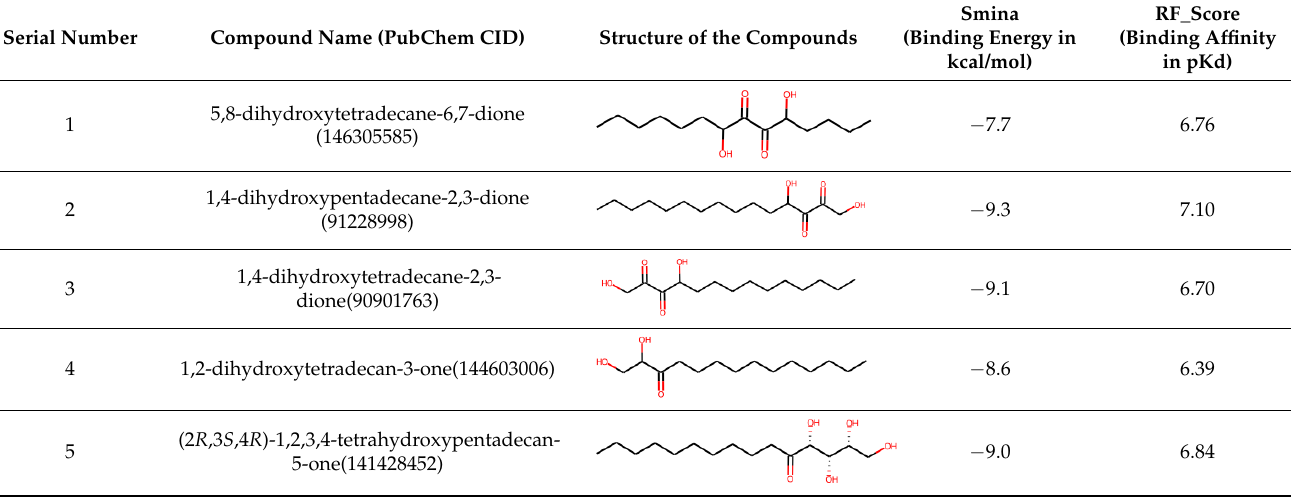
Figure 3. All these analyses were performed using Maestro 12.3 ( Schrödinger Release 2022- 2 ; Maestro, Schrödinger, LLC.: 2021) and Chimera [27,28]. For brevity, these molecules, as well as their complex with LuxP, will be referred by their serial number in Table 1 from here on. Table 1. Docking energy of the top five hit compounds and their amino acid interactions.